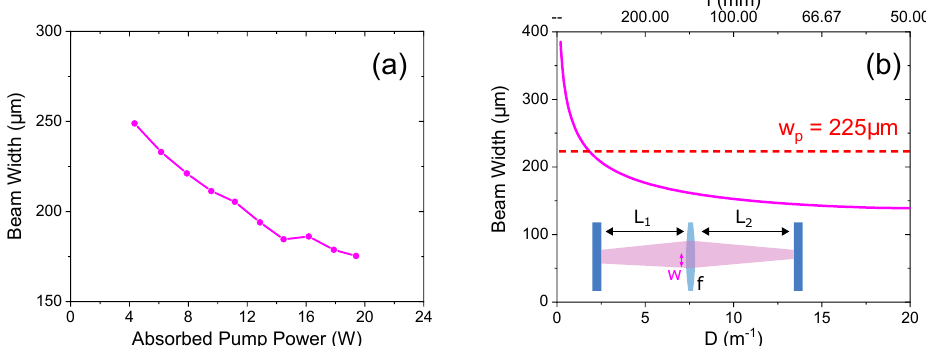
Figure 5. ( a ) Experimental TEM 00 beam width radius (based on measured beam width and corrected using M 2 value) as a function of the absorbed pump power for the plane-plane cavity. ( b ) Theoretical calculation of TEM 00 beam width radius at the thermal lens as a function of its dioptric power D = 1/ f with L 1 = 35 mm, L 2 = 40 mm and λ = 760